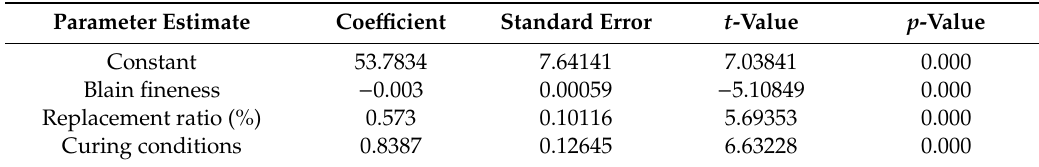
Figure 14. Comparison of the experimental and predicted values of the relative dynamic modulus of elasticity.